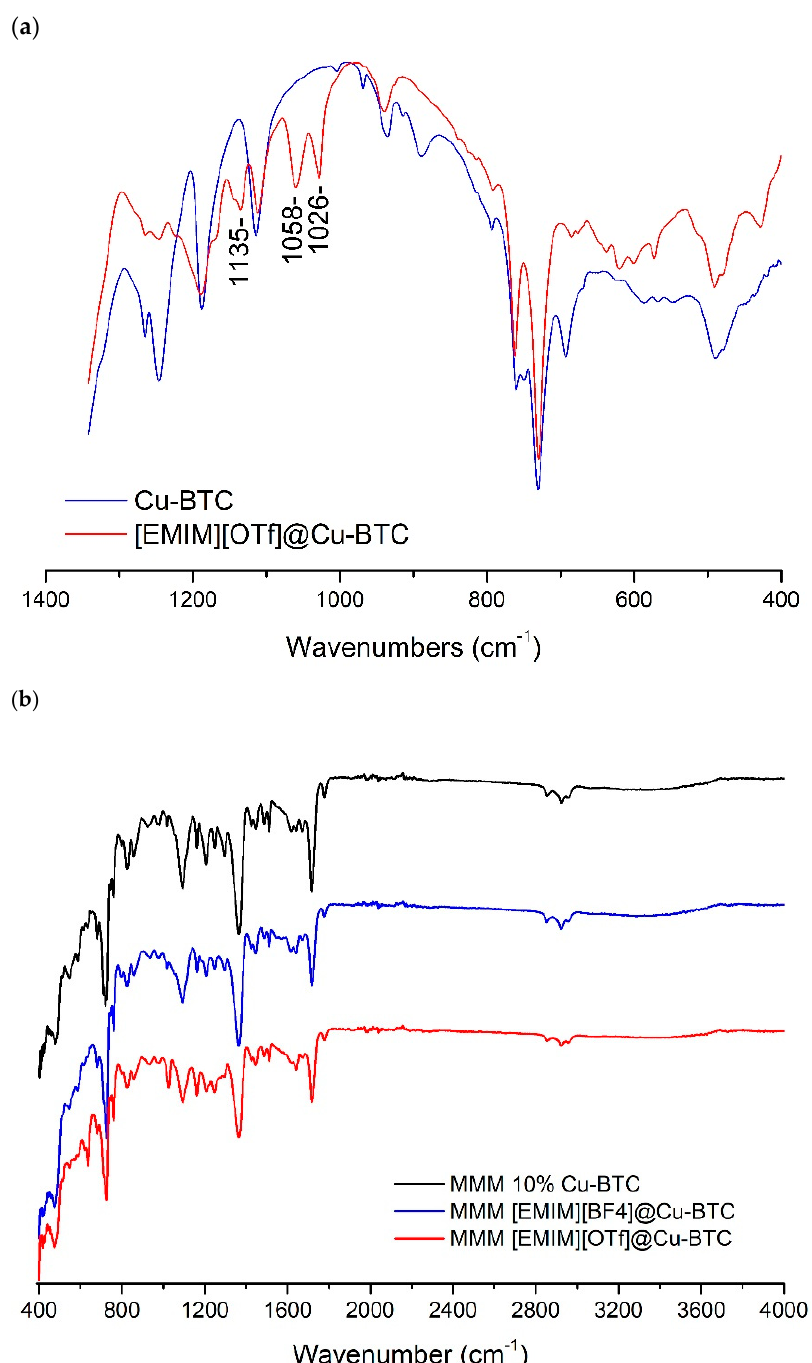
Figure 3. ( a ) Partial infrared spectra of Cu-BTC and EMIMOTf@Cu-BTC; ( b ) FTIR spectra of the mixed matrix membranes prepared in this work.